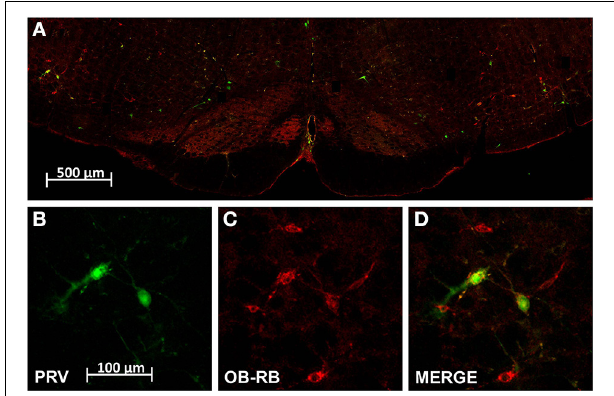
FIGURE 2 | Dual localization of leptin receptors (ObRb; red) and pseudo rabies virus infected cells (PRV; green) resulting from renal PRV injection. (A) Is a low power montage of the complete ventral half of the medulla at the level of the RVLM. (B–D) Are high magnification of cell cluster in left RVLM shown in (A) demonstrating PRV positive RVLM neurons (B) , ObRb expressing RVLM neurons (C) , and double labeled RVLM neurons (D) . Scale bar = 100 microns.